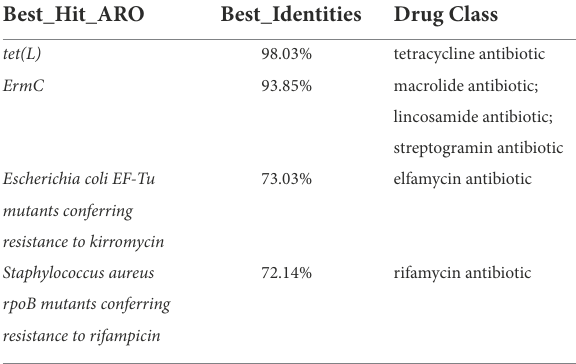
TABLE 2 Antimicrobial resistance genes present in L. salivarius S01. TABLE 3 Antibiotic sensitivity of L. salivarius S01 strains to resistance